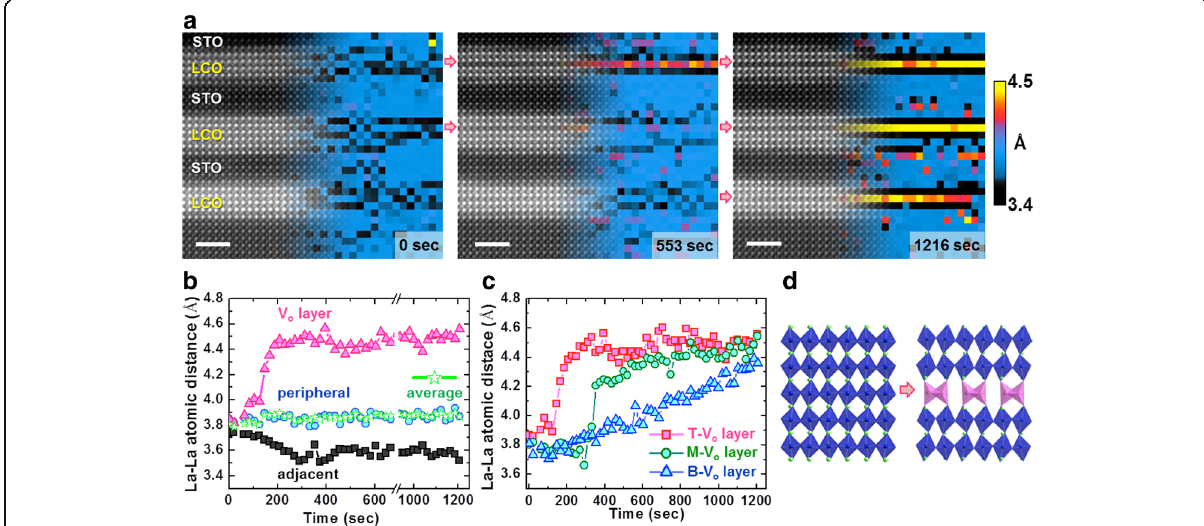
Fig. 16 Beam-induced oxygen vacancy ordering in a LaCoO 3 /SrTiO 3 superlattice grown on a SrTiO 3 substrate viewed along the [100] direction. a Sequential ADF images overlaid with corresponding maps of the out-of-plane interatomic La-La spacings. b Average spacings in the central V o layer (red curve), the adjacent (black curve), and peripheral (blue curve) layers within the top LCO block as a function of time; green (star) curve gives the overall average, suggesting that the beam primarily induces redistribution of existing vacancies rather than vacancy injection. c Comparison of the evolution of interatomic spacings in the oxygen-depleted planes of the top (T), middle (M), and bottom (B) LaCoO 3 blocks; the differences are attributed to differences in thickness due to the wedge geometry of the sample. d Atomic model of the ordering transition; La atoms are shown in green, CoO 6 octahedra in blue, and CoO 4 tetrahedra in purple. Reproduced from Jang et al. 2017. Copyright 2017 American Chemical